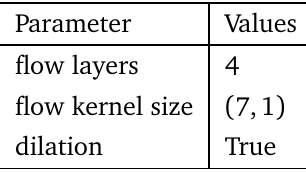
Table 13: ConvF model